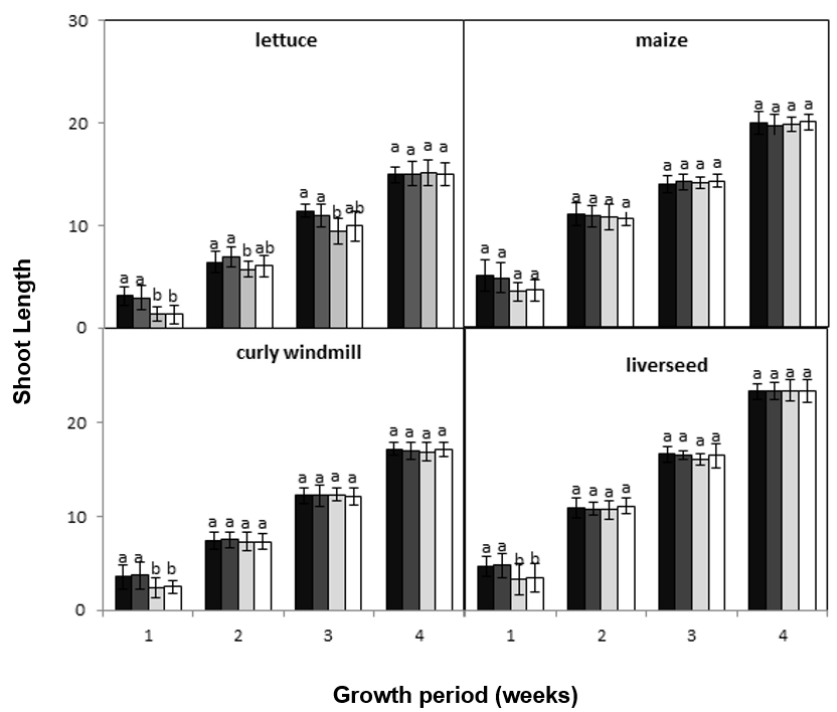
Figure 2. Shoot length attained by lettuce, maize, curly windmill grass, and liverseed grass seedlings when grown in a soil from a parthenium weed-infested site, either collected from the 0 to 10 cm (light grey) or 10 to 20 cm (white) depth; and from a non-infested soil collected from the 0 to 10 cm (dark grey) or 10 to 20 cm (black) depth. Error bars represent two standard deviations from the mean as calculated for three replicates of six seedlings in three pots. Means within species and growth periods that do not share the same letter are significantly different from one another at p > 0.05.